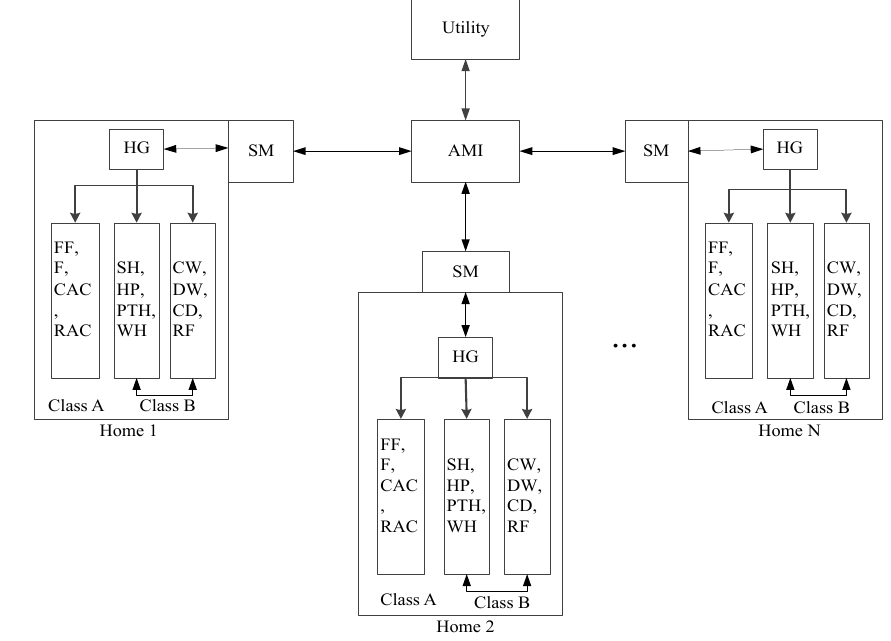
Figure 2. Proposed system